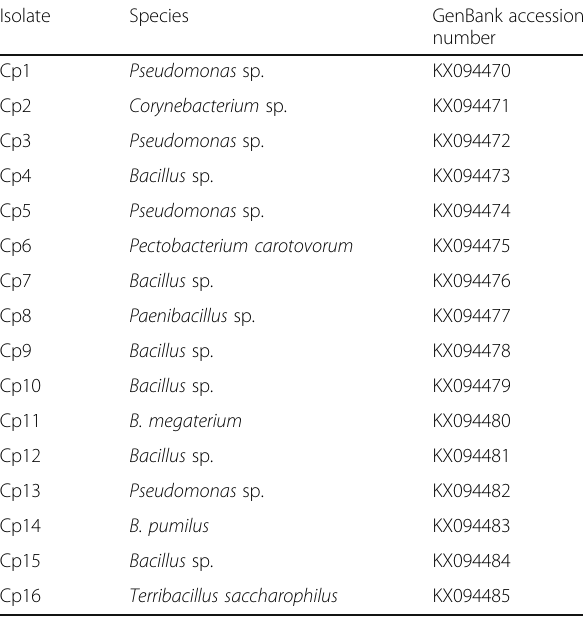
Table 4 The proposed identification results of the bacterial isolates and their GenBank accession numbers for 16S rRNA gene